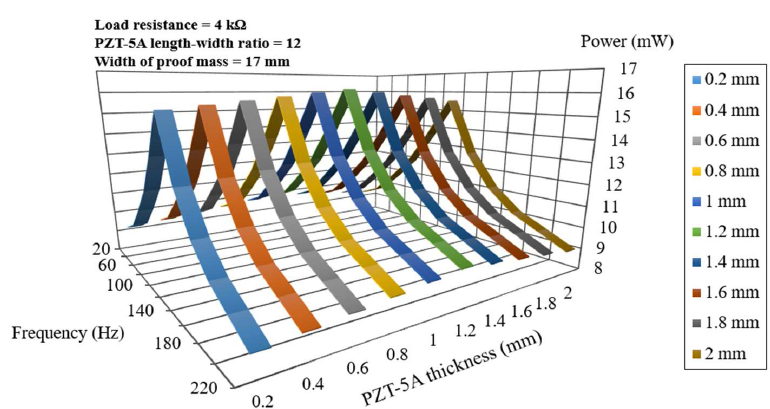
Figure 4. Output power at varying widths of the proof mass.